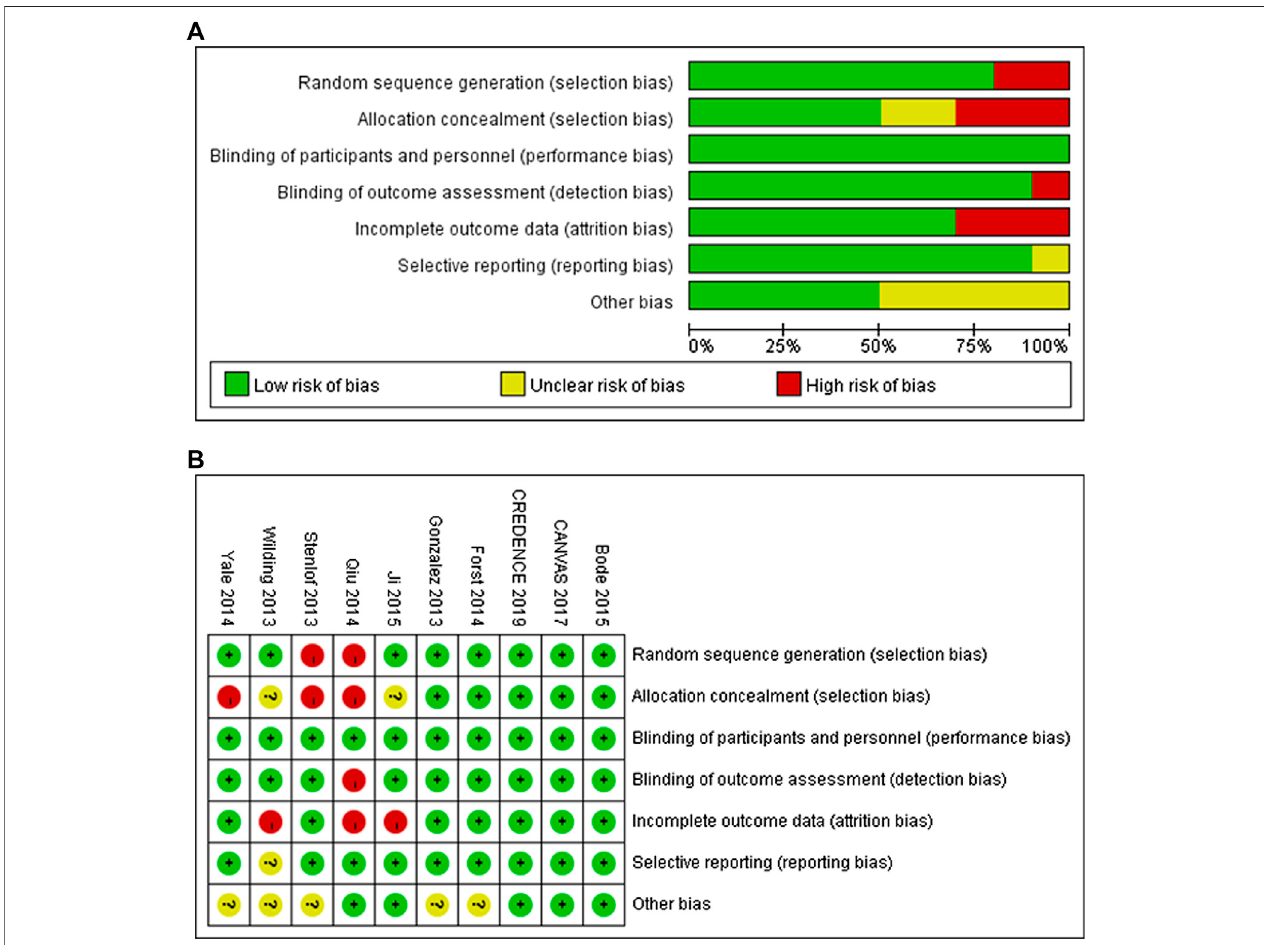
FIGURE 2 | Risk of bias graph (A) and risk of bias summary (B) for included RCTs.